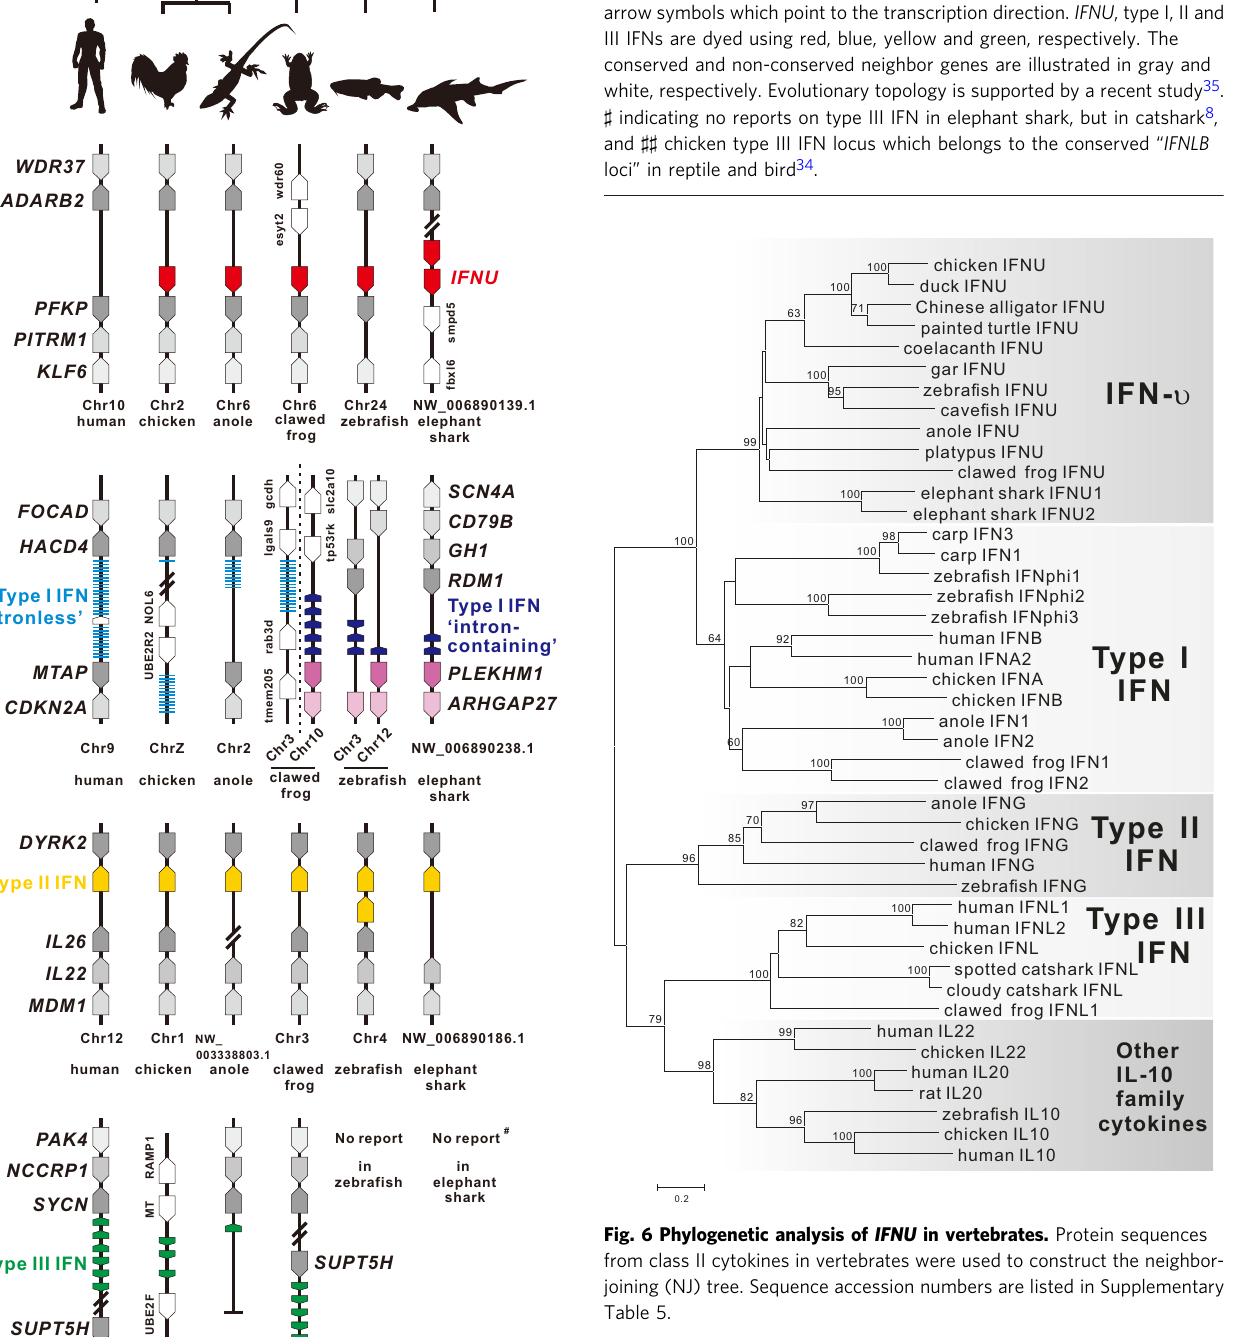
Fig. 6 Phylogenetic analysis of IFNU in vertebrates. Protein sequences from class II cytokines in vertebrates were used to construct the neighbor- joining (NJ) tree. Sequence accession numbers are listed in